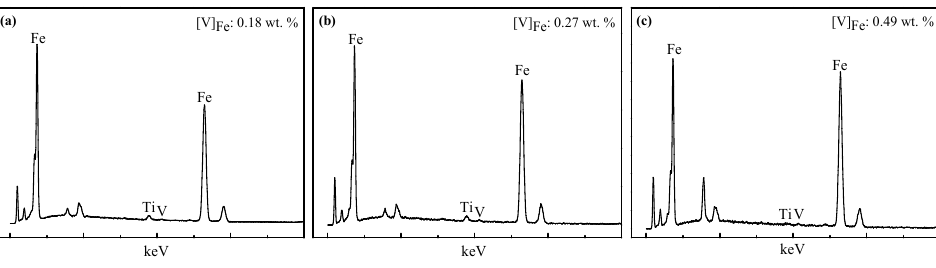
Figure 7. EDS analysis of metallic iron particles: ( a ) 1300 °C; ( b ) 1350 °C; and ( c ) 1400 °C.